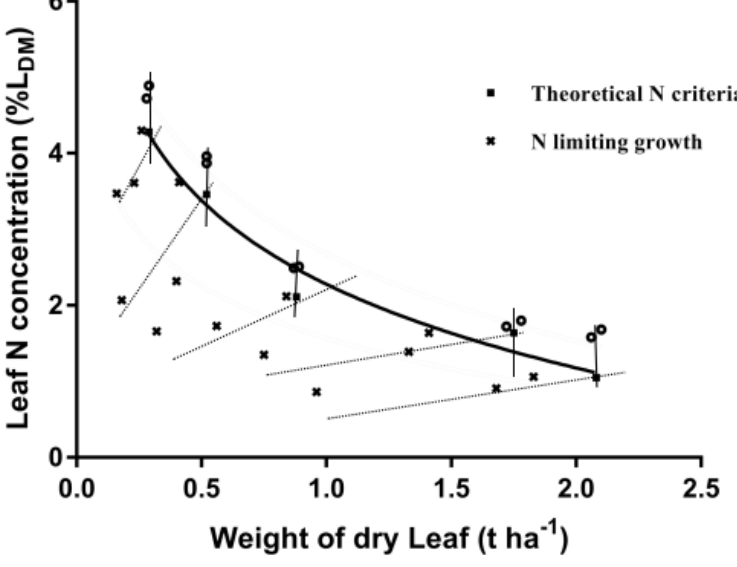
Figure 1. Critical nitrogen concentration curve.